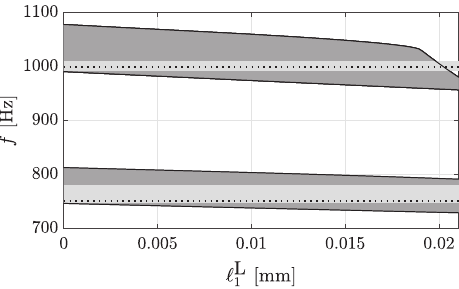
Figure 9. Cutoff frequencies found using asymmetric division (dark grey region) of acoustically regular conical lattices with global cutoff frequencies at 750 Hz (bottom) and 1000 Hz (top) for different initial cell length ‘ L . The characteristic frequencies 1 ¼ f T f P are marked by a dashed line, and the cutoff transition c c band f R by light shaded grey. t